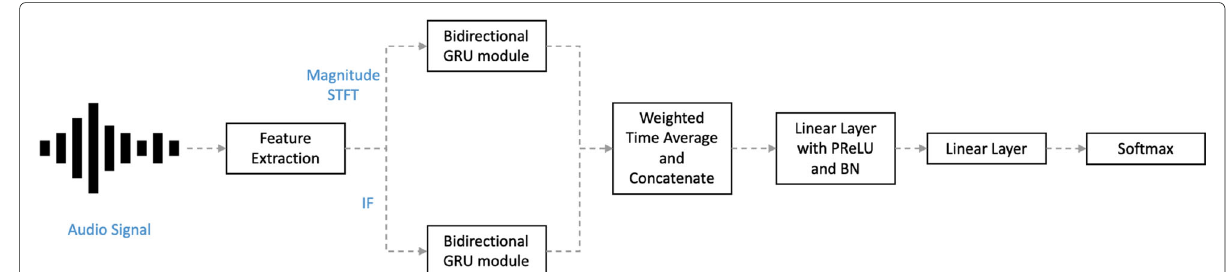
Fig. 1 Network architecture of our GRU based VAD model. The model uses 800 ms audio signal sampled at 32 kHz as input, extracts magnitude (STFT) and Instantaneous Frequency (IF) spectrograms using feature extraction module. These two spectrograms are then normalized using Batch Normalization (BN) and passed through two parallel two layered Bi-GRU module. The outputs of the GRUs are time averaged, concatenated and passed through linear layer (128 dimension) followed by a Parametric ReLU (PReLU), Batch Normalization (BN), linear layer (2 dimensional) and a softmax to generate probability of speech and